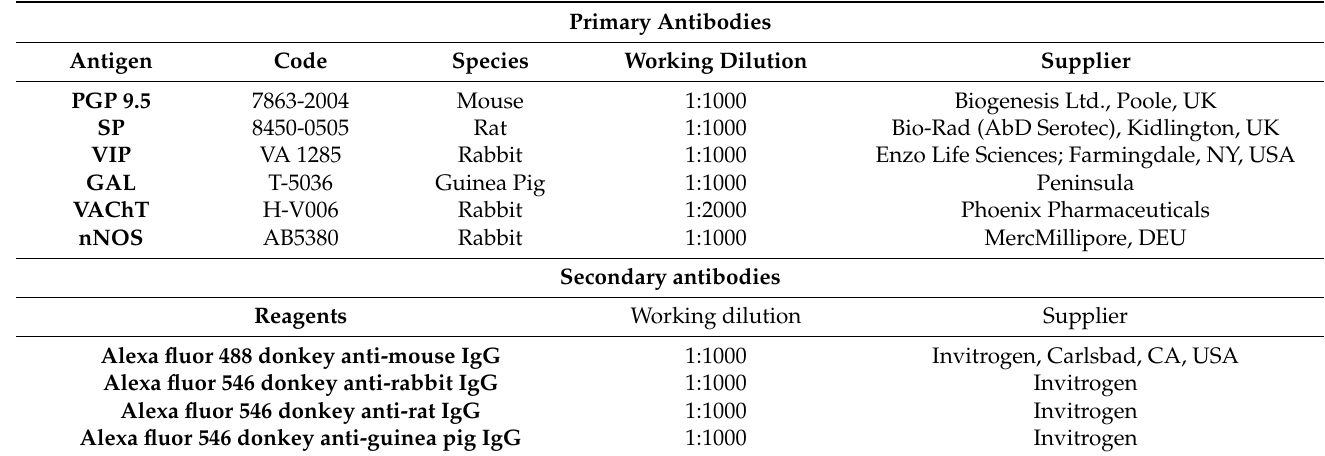
Table 1. List of antisera and reagents used in immunohistochemical